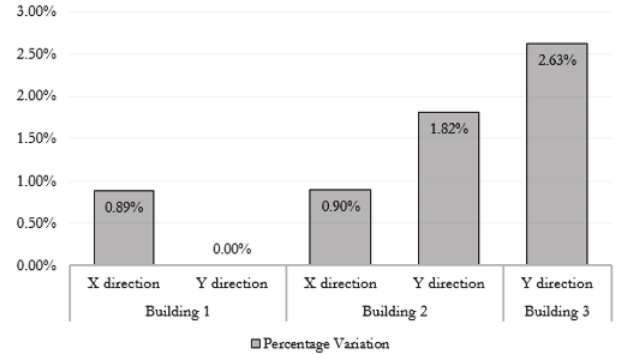
Percentage variation among the coefficients of the real